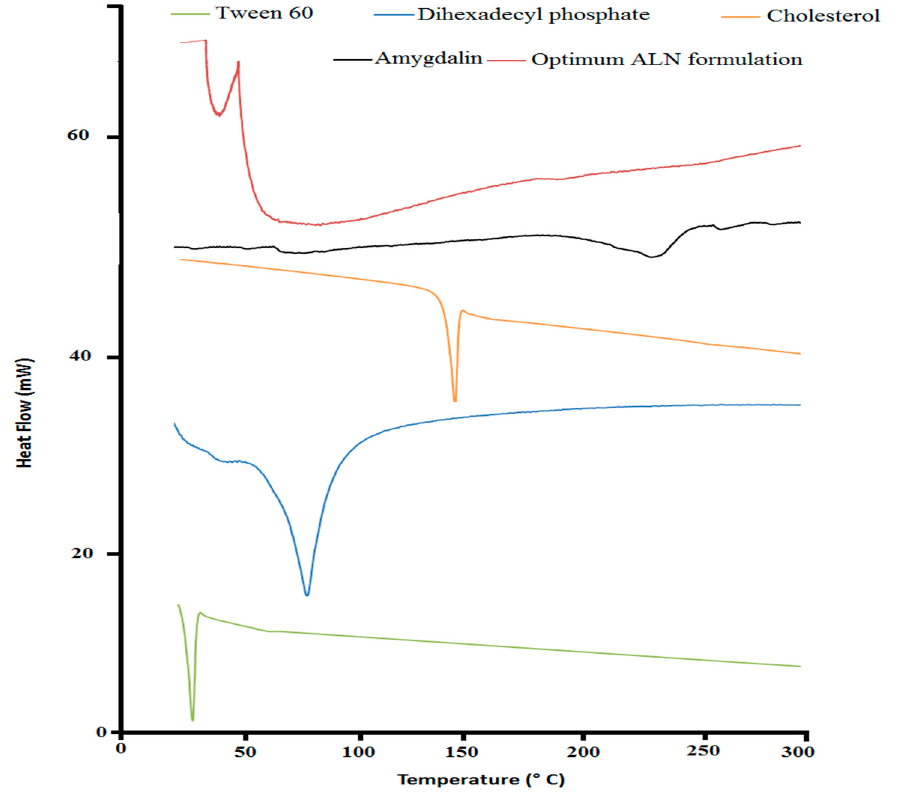
Figure 1. DSC of optimum ALN formulation and its individual constituent.